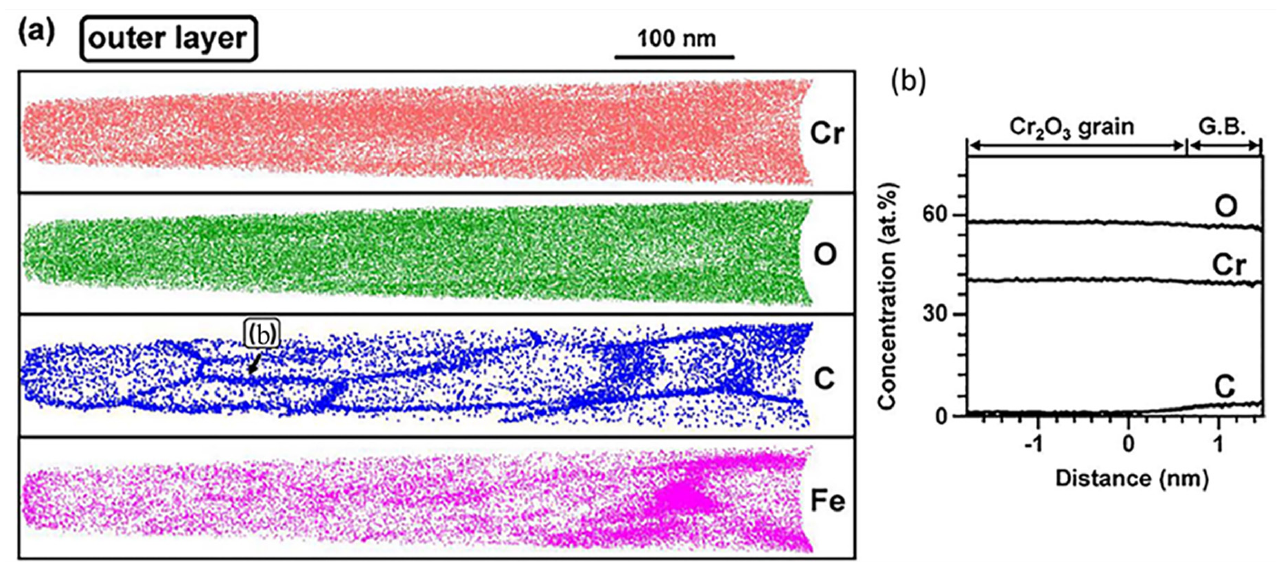
Figure 17. ( a ) Atom maps of slices through oxide tips of outer layer of the Cr 2 O 3 scale on Fe20Cr reacted at 650 °C in Ar-20%O 2 (24 h) and then in Ar-20%CO 2 (70 h). ( b ) Proxigram of species in the outer layer with respect to the a C 2 O 2+ 0.7 at. % isoconcentration surface from the area indicated by an arrow in ( a ) [101]. Reproduced with permission from Elsevier.